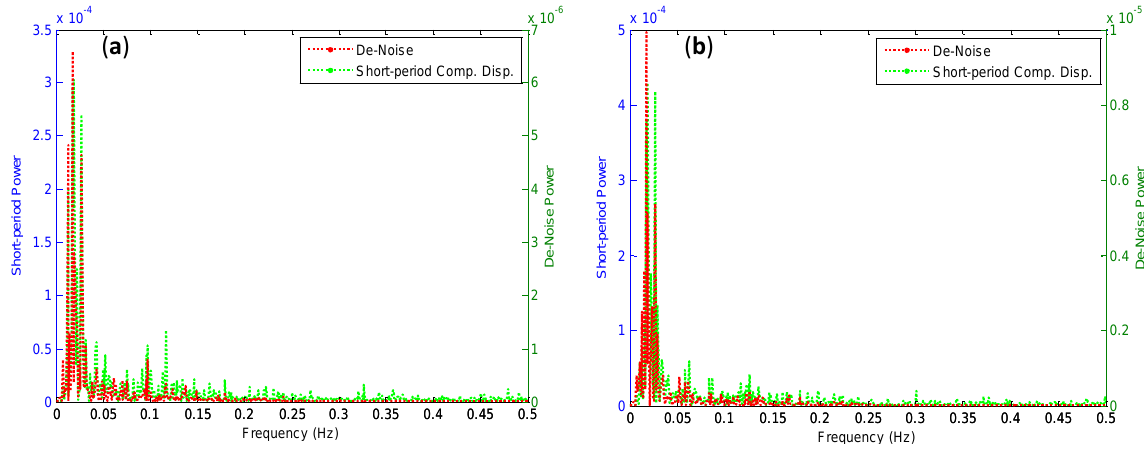
Figure 10. Frequencies of short period before and after de-noise GPS monitoring point ( a ) x, ( b )